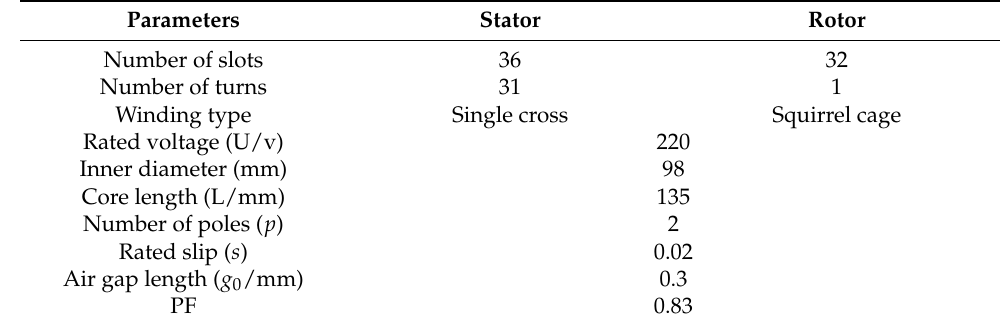
Table 2. Y100L2-4 Motor parameters.